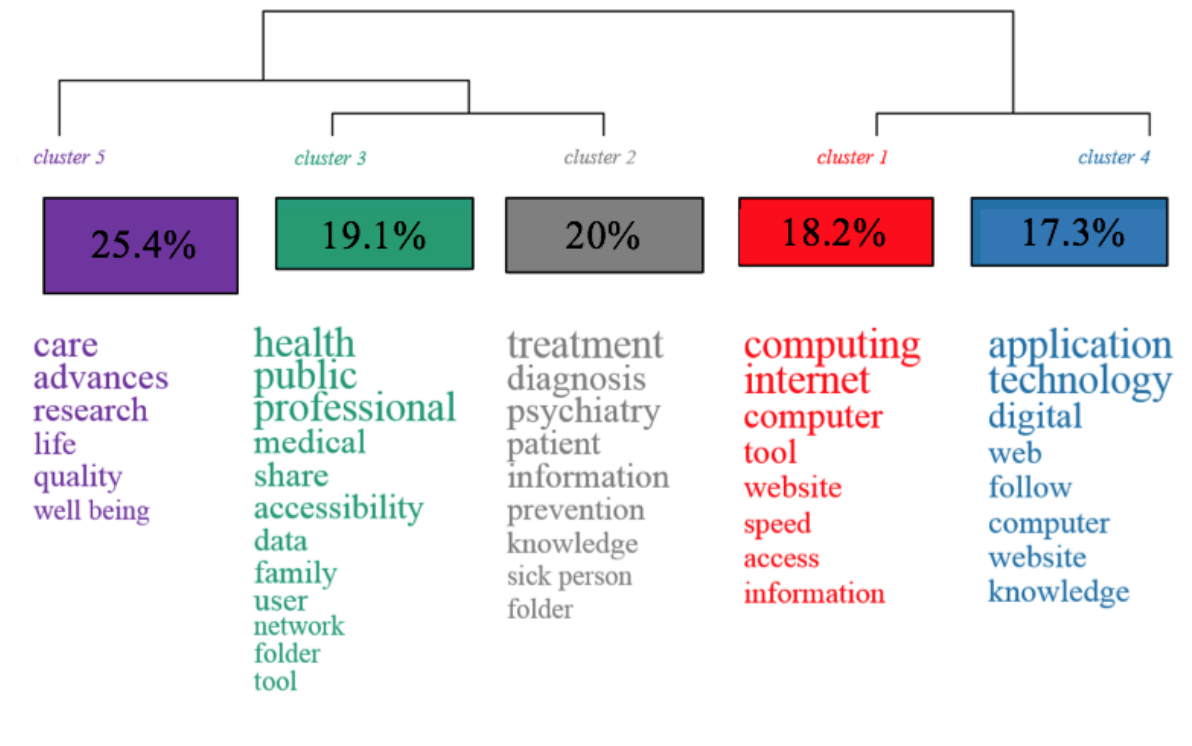
Figure 1. Classification of words used according to their frequency of co-citation within the same text segment by all participants in the 5 clusters, with P <.05 for all